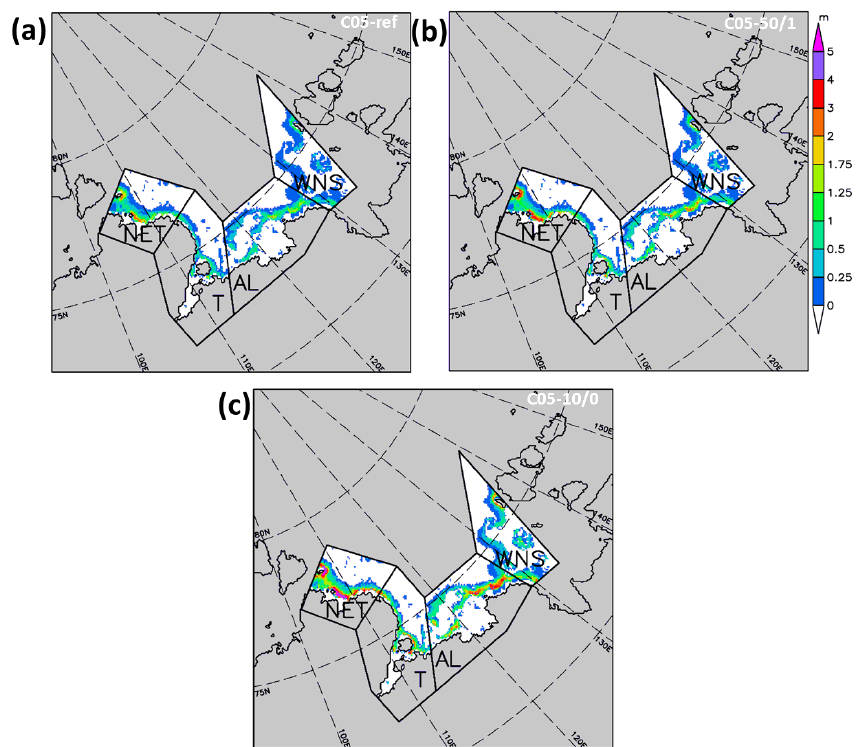
Figure 11. Total sea-ice production (m) within the Laptev Sea polynyas in the winter period 2007/2008 simulated by (a) C05-ref (reference), (b) C05-50/1 (realistic), and (c) C05-10/0 (open